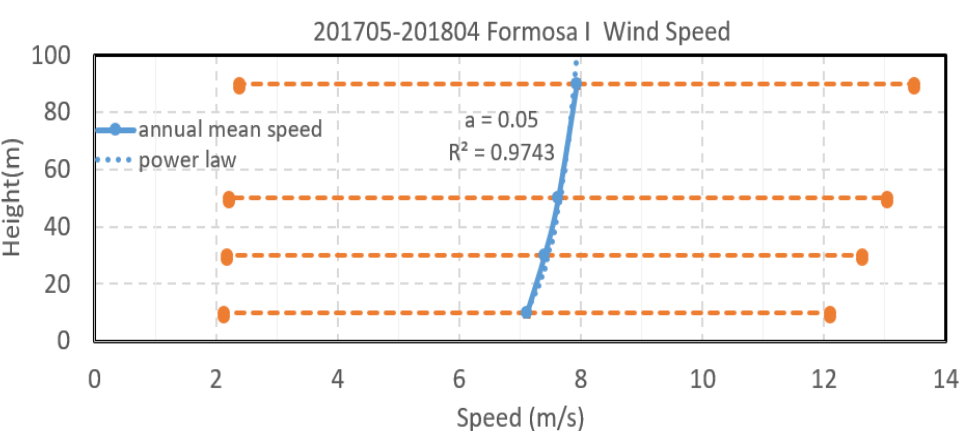
Figure 2. Annual mean speed (blue line) and standard deviation (orange dash line).